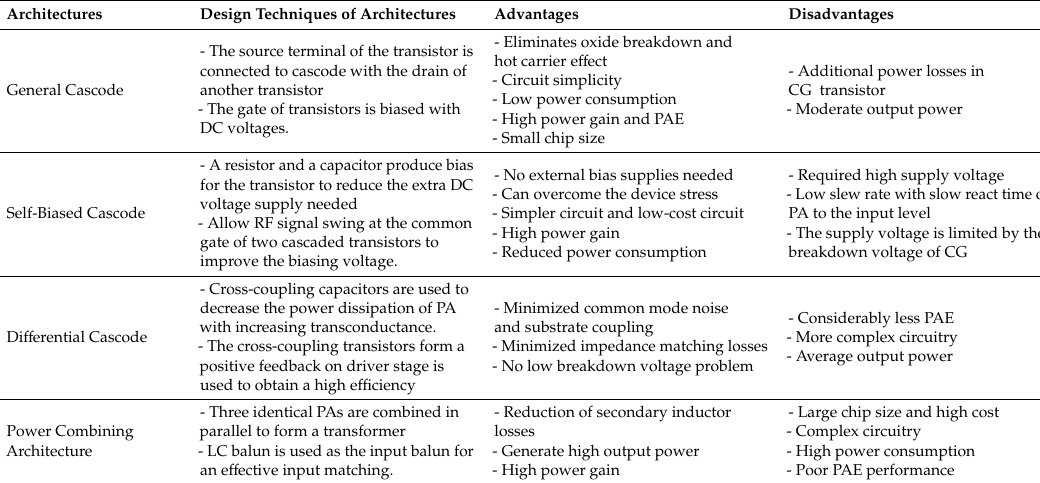
Table 1. Performance analysis between di ff erent PA design